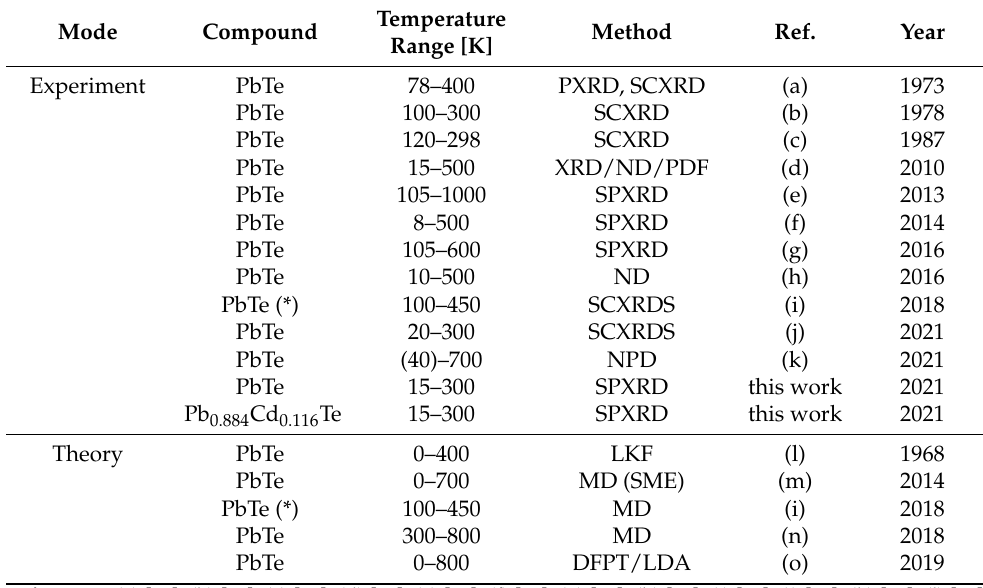
Table 4. Temperature ranges for selected earlier studies of the experimental and theoretical mean studies, the ranges refer to the lower and upper limit of the